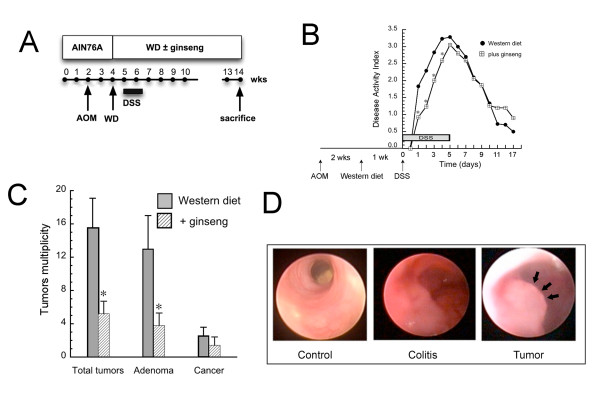
Ginseng inhibits colitis and colonic tumorigenesis in mice on Western diet. A. Protocol for tumor induction. Mice received AOM at wk 2. WD was initiated at wk 4 and DSS was given beginning in wk 5. Mice were sacrificed in wk 14. B. Time course of DSS colitis. Animals were treated as shown in Figure 1A. DSS induced colitis was scored as disease activity index (DAI) based on weight loss, diarrhea and bleeding as described [38]. Values were expressed as mean ± SD (n = 7 AOM/DSS, n = 5 AOM/DSS + ginseng; *p < 0.05, compared to Western diet alone). Ginseng significantly delayed onset of colitis and appeared to limit peak inflammation. C. Tumor multiplicity. Mice were treated as described in Figure. 1A and sacrificed 12 wks after AOM. Tumor histology was determined by standard criteria. Tumor multiplicity was calculated using the Wilcoxon-Mann-Whitney test (n = 7 AOM/DSS, n = 5 AOM/DSS + ginseng; *p < 0.05 compared to AOM/DSS alone). Note that ginseng significantly inhibited total tumor multiplicity and the number of adenomas/mouse. D. Colonoscopy detects colitis and tumors. Shown are representative colonoscopic views of control mice (left panel), mice with colitis 5 days after DSS (middle panel) and mice with tumors 12 wks after AOM (right panel). Note the increased mucosal erythema in the colitis-bearing mouse and intraluminal mass in the tumor-bearing mouse (black arrows).